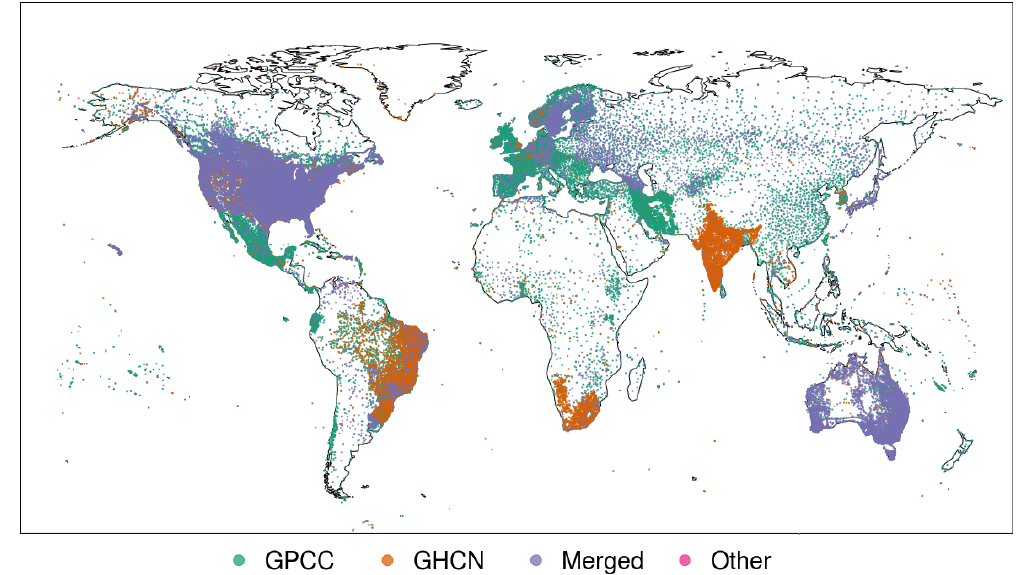
Figure 2. Distribution of stations colour coded by source. “GPCC” refers to stations hosted by Deutsche Wetterdienst, “GHCN” refers to stations hosted by National Centers for Environmental Information (NCEI), “Merged” refers to stations that have been identified as identical in two or more archives resulting in a merger of the time series and finally “Other” refers to the Russian and Argentinian stations that were added by